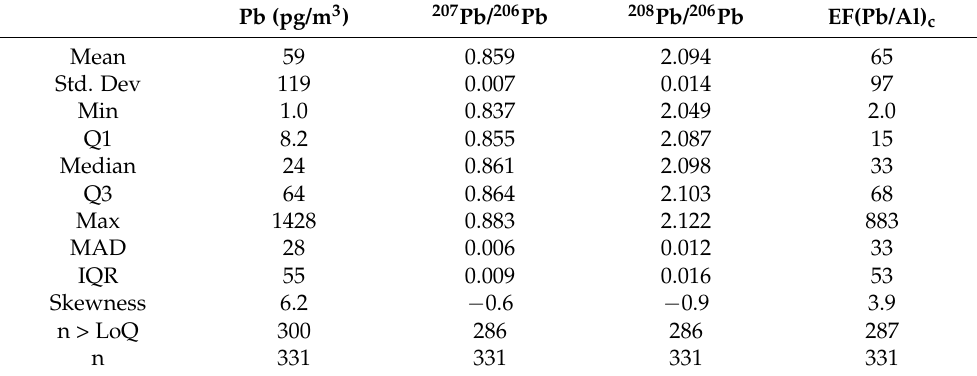
Table 1. Summary statistics for Pb concentration, isotope ratio values, and crustal enrichment factors (EFs) for PM 10 samples collected at Ny-Ålesund from 2010 to 2018. Median absolute deviation (MAD) and interquartile range (IQR) are reported as robust estimations of data dispersion. Data above the limit of quantification of the analytical techniques are reported as n >